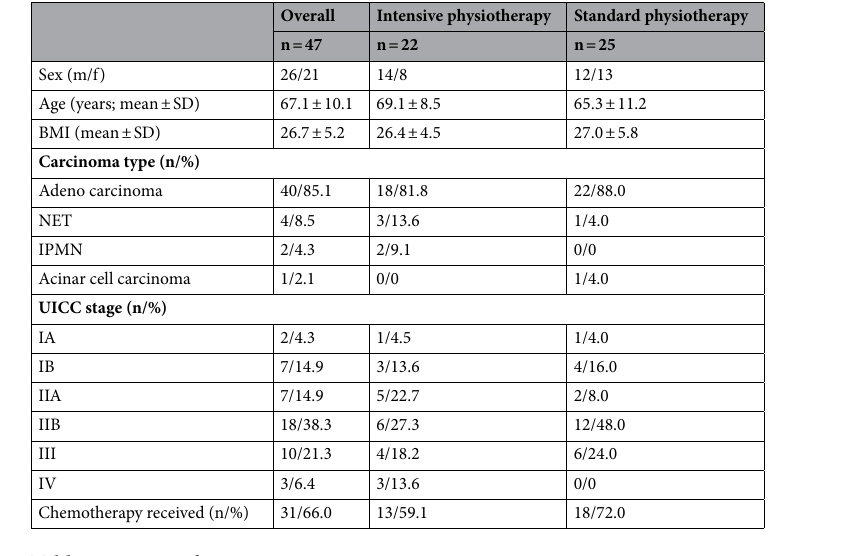
Table 1. Patient